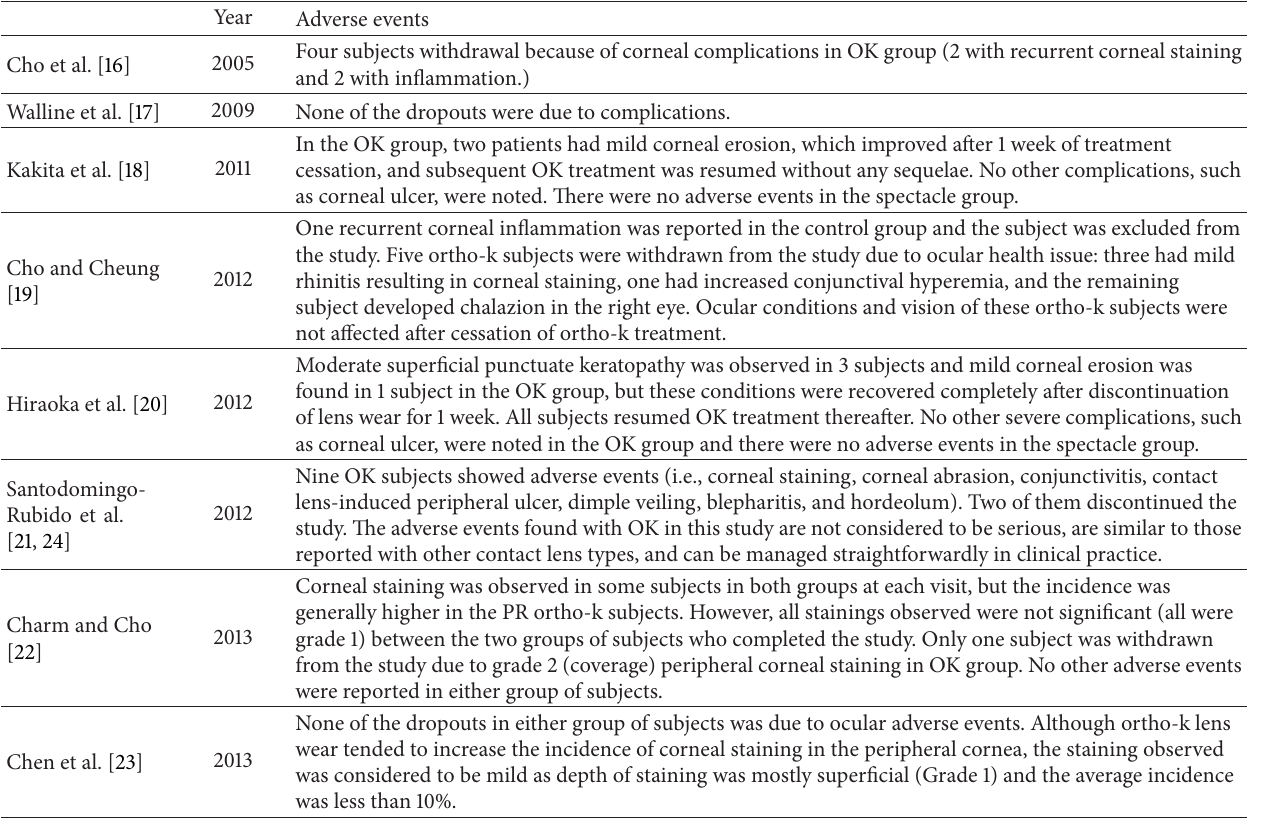
Table 7: Adverse events of included